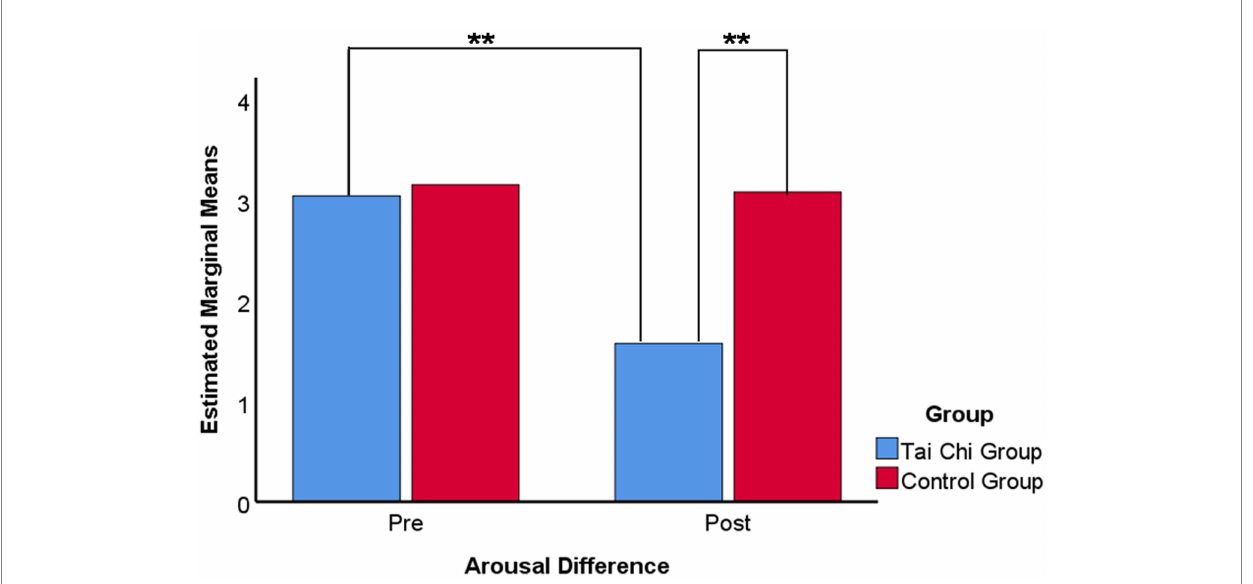
FIGURE 7 Multiple means comparison of arousal difference on emotion regulation ability. Bonferroni adjustment for multiple comparisons. *** p -value <0.001, ** p -value <0.01, * p -value <0.05.